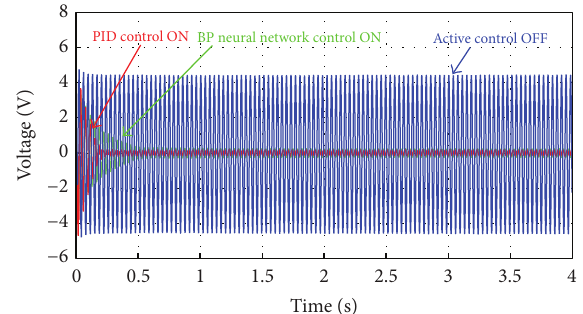
Figure 13: Time history plots from exciter stimulation tests of active sting damper with active control ON/OFF.